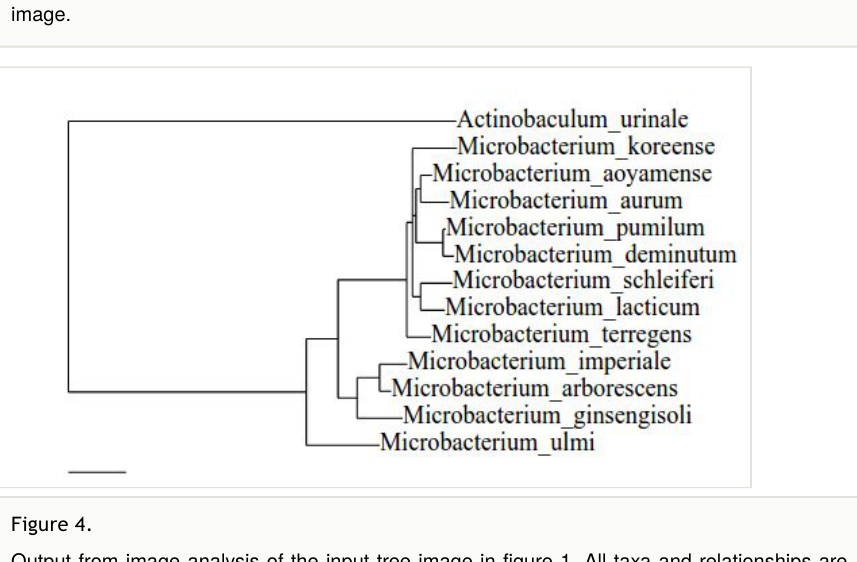
Number of leaves (terminal taxa) in each of 1614 source tree images (blue) and number of leaves recovered-from each image (orange). The modal number of taxa recovered per image was 12, the median was 13, and the mean was 13.96. The modal number of taxa not recovered from the trees was 2, the median was 5 and the mean was 7.15. The image mining process is lossy since most output tree fi les did not recover all of the taxa from the source image.